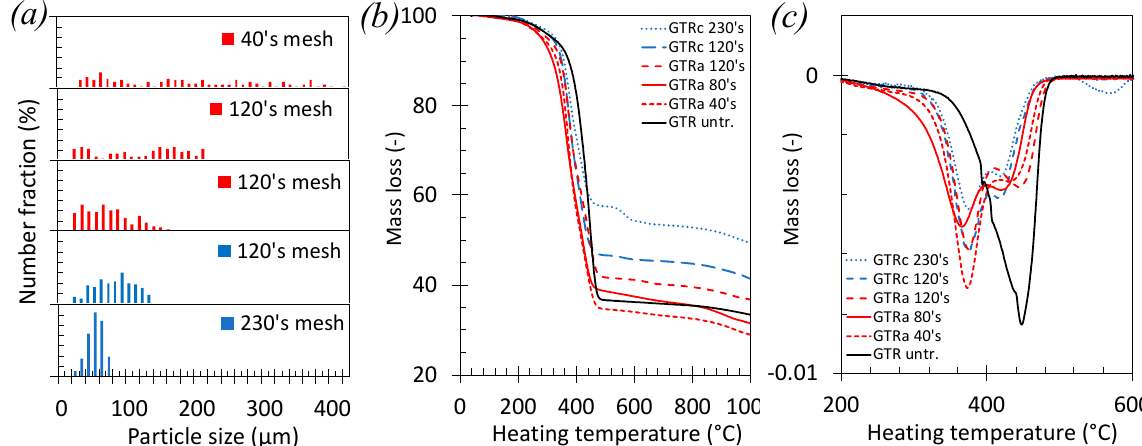
Figure 1. ( a ) Size distribution of dry ambient grinding and cryo ‐ grinding of GTR particles, ( b ) mass loss versus heating temperature obtained from TGA measurements and ( c ) first derivative of the mass loss versus heating temperature.